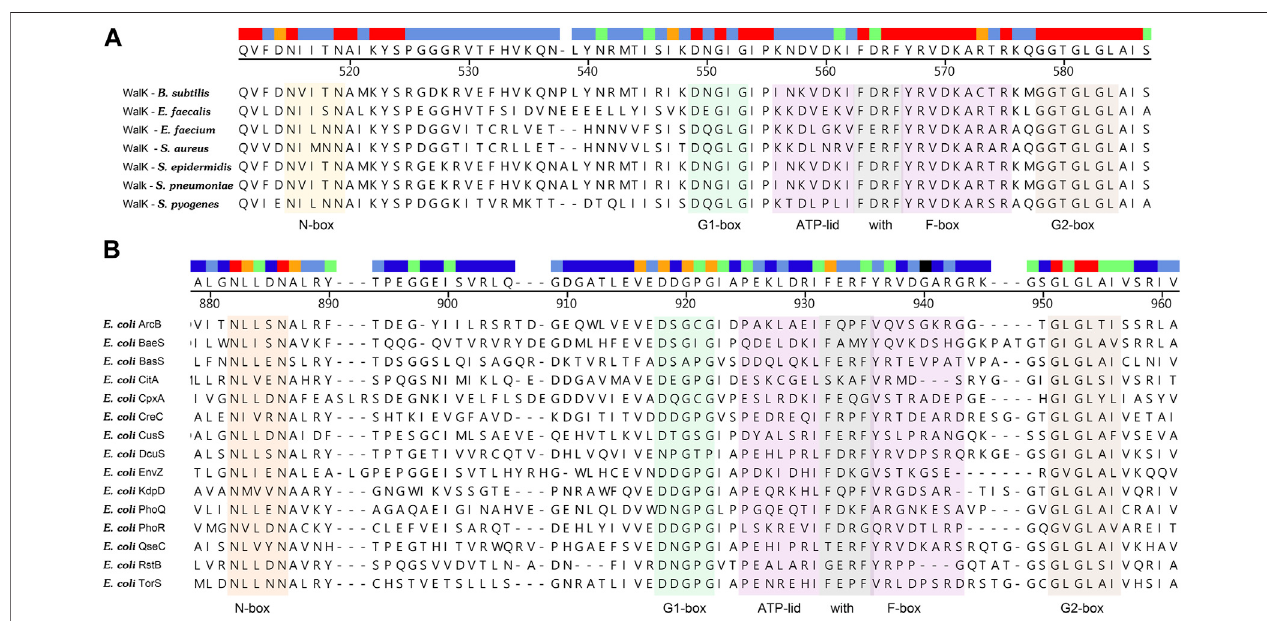
FIGURE2 |(A) Sequence alignmentof CAdomains ofWalK from seven importantgram-positive pathogens. The N-box, G1-box, G2-box, F-box, and ATP-lid are colored in orange, green, light brown, gray, and purple, respectively. The high conservation of CA catalytic site indicated that inhibitors targeted at this site will possess broad-spectrum antibacterial activity. (B) Sequence alignment of CA domains of fi fteen kinds of HKs from E. coli . High sequence similarities of the CA domain from different HKs implied that a HK inhibitor acting on multiple targets is a promising strategy to slow down antibacterial resistance (Bem et al., 2015).